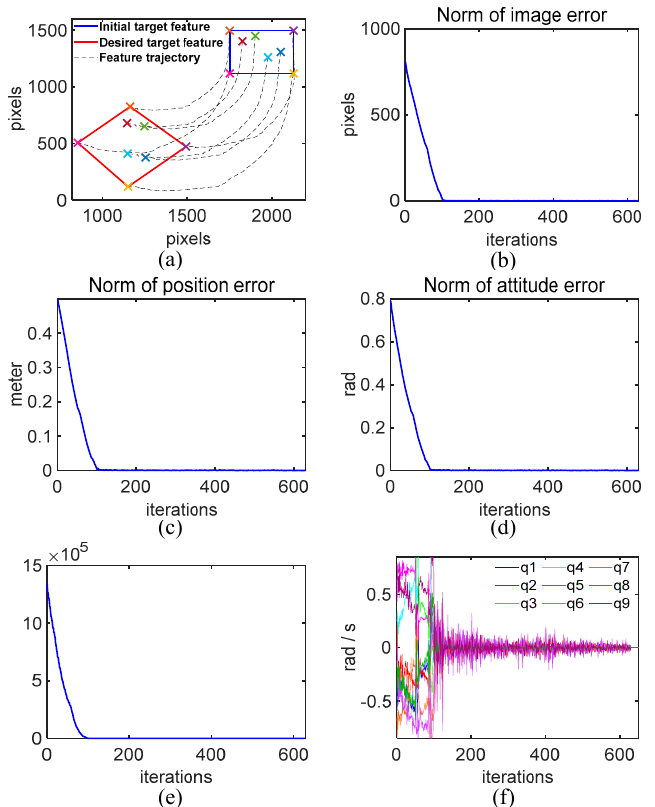
Figure 5. Detailed result of the improved PHUVS with the KF-SVSF method. ( a ) Trajectories of partial